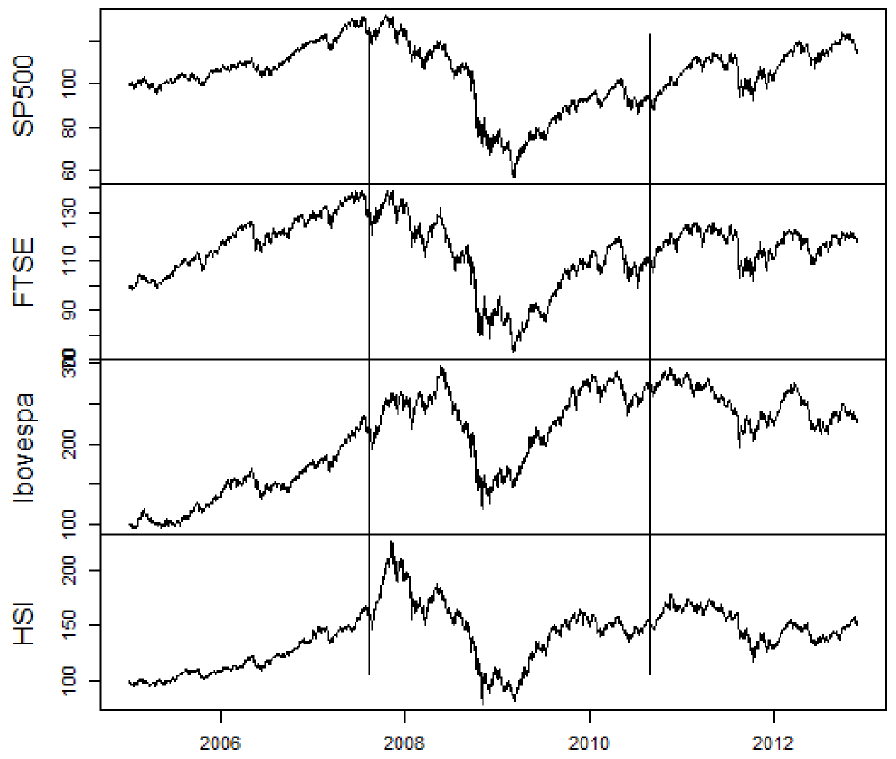
Figure 1. Daily prices on basis 100 of S&P500, FTSE100, Ibovespa and HSI from January 2005 to November 2012. Vertical lines represent the subdivision into non-crisis, Sub-prime crisis and Eurozone crisis.